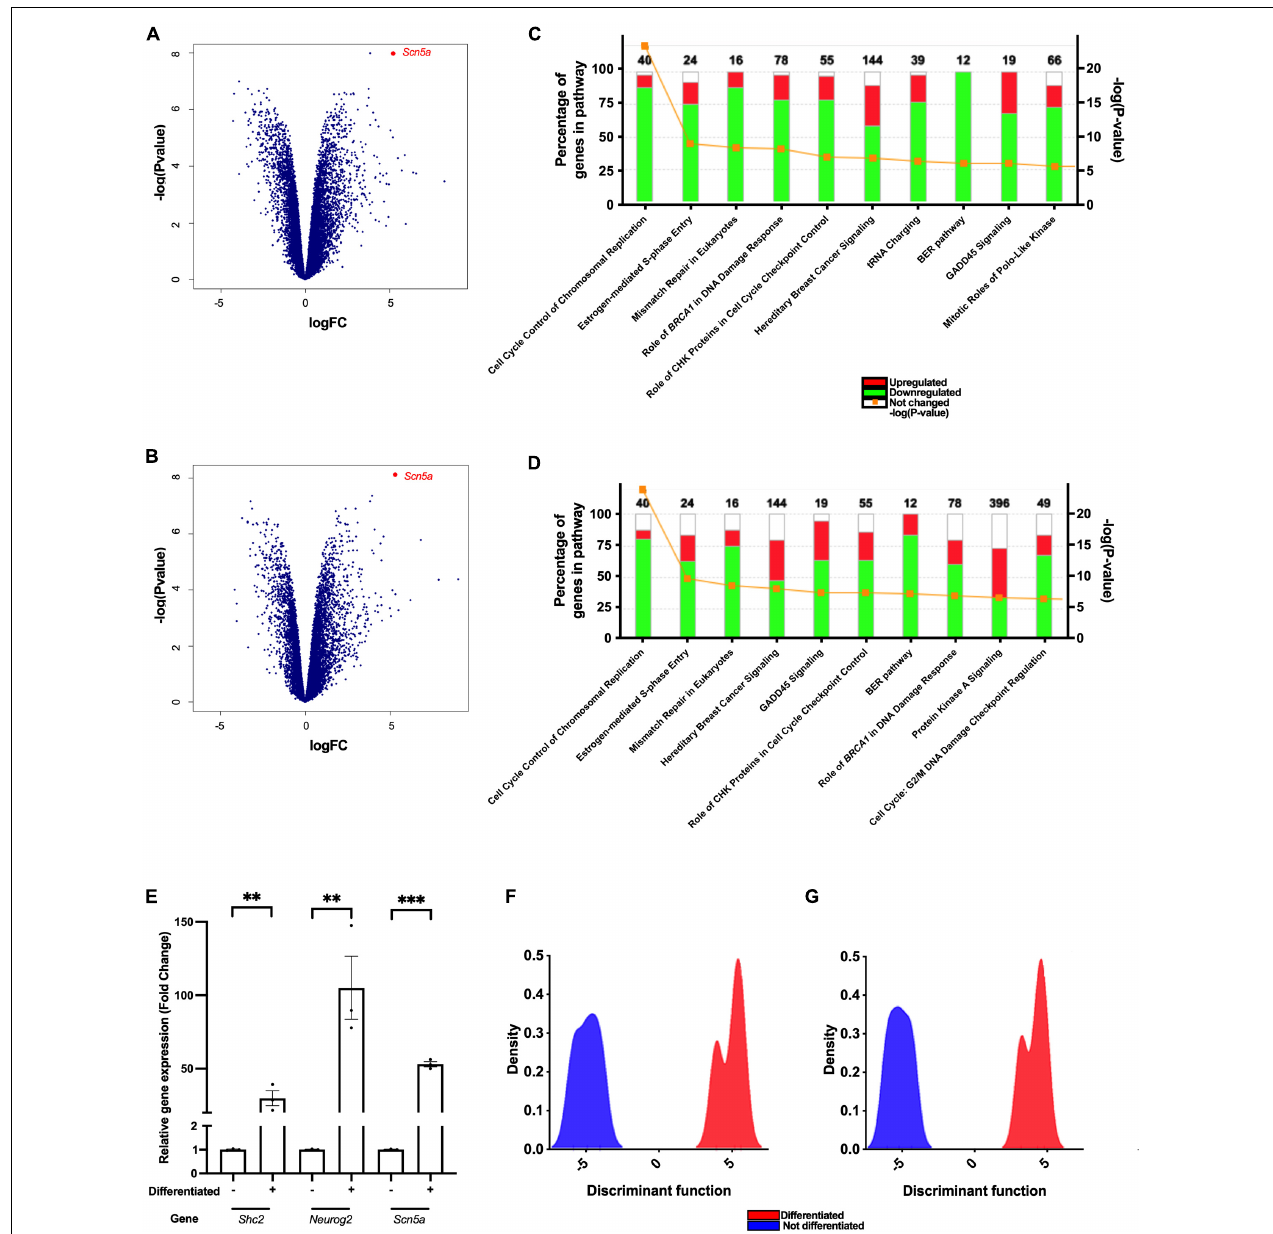
FIGURE 2 | Differentiation of F11 cells enhances the transcription of genes related to the regulation of membrane potential, neuritogenesis and neuronal differentiation. Cloud plot depicting changes in the expression of (A) mouse and (B) rat genes after differentiation of F11 cells. Points represent the mean of the values obtained from three independent RNA-Seq experiments performed using different samples. Changes observed in genes belonging to (C) mouse and (D) rat signaling pathways after differentiation of F11 cells. (E) Comparative quantification of the Scn5a , Shc2 and Neurog2 gene expression in non-differentiated and differentiated F11 cells employing RT–qPCR. Values shown are the means ± SD of three independent assays ( n = 3) with three replicates per measurement. ∗∗∗ p < 0.001; ∗∗ p < 0.01 (Student’s t- test). Discriminant analysis of principal components of (F) mouse and (G) rat genes comparing non-differentiated and differentiated F11